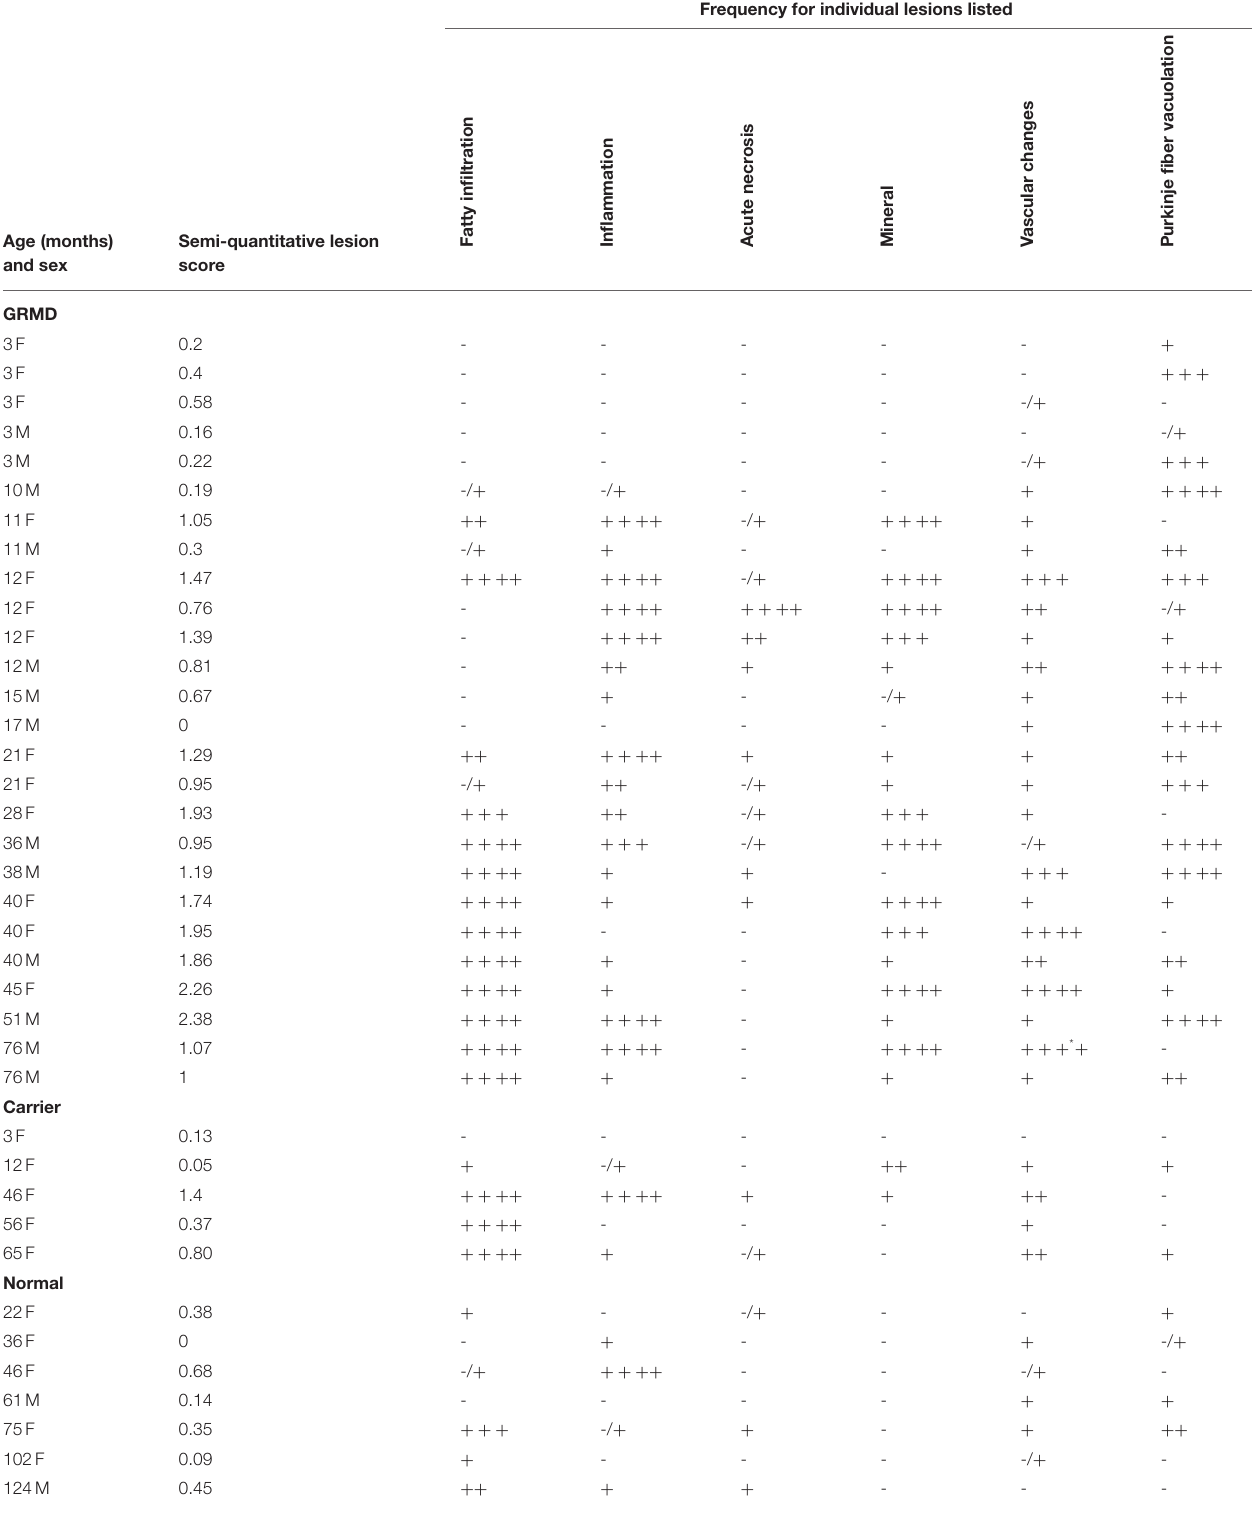
TABLE 3 | Lesion frequency across the heart for individual